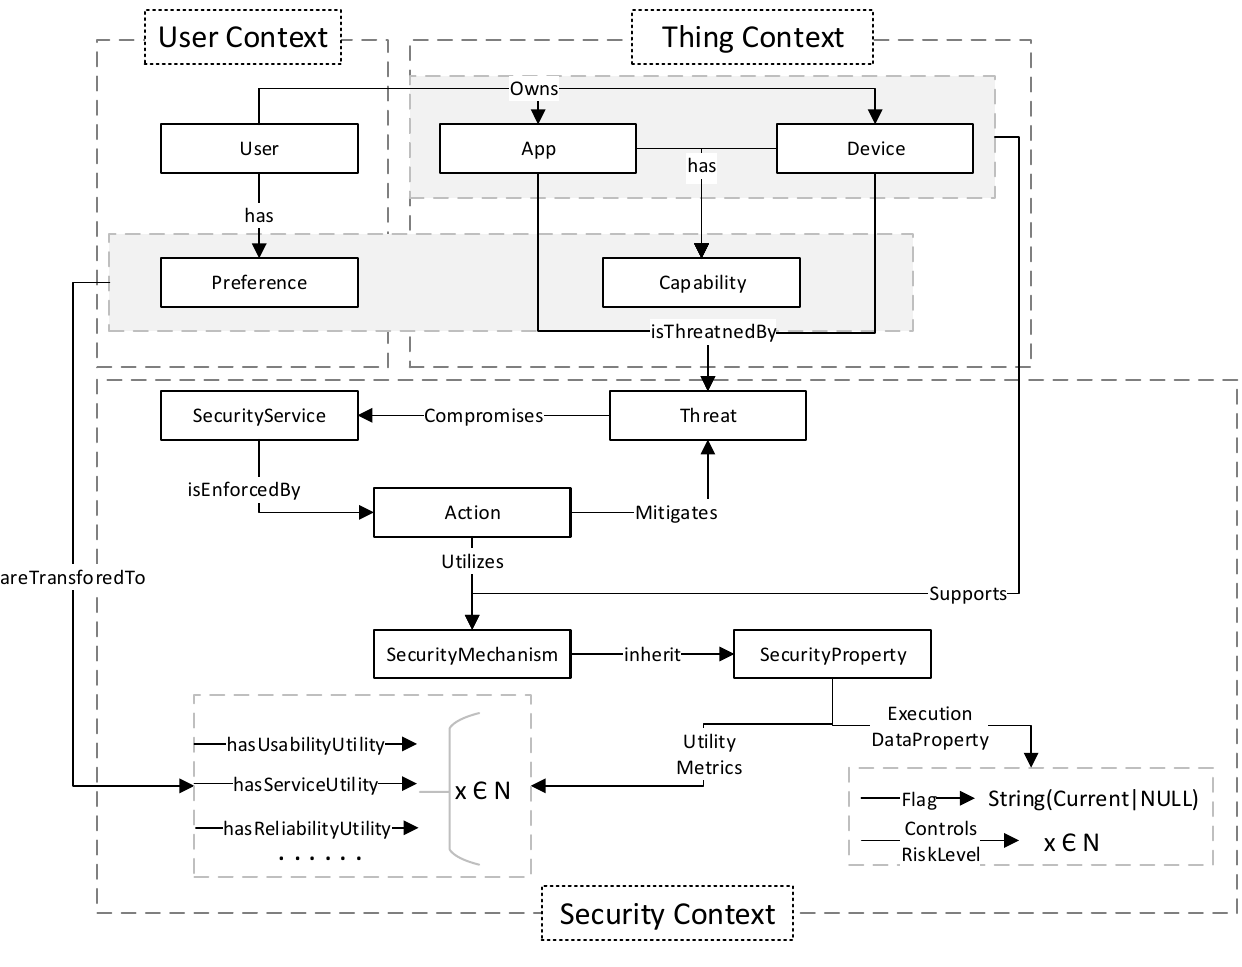
Figure 10. Security adaptation